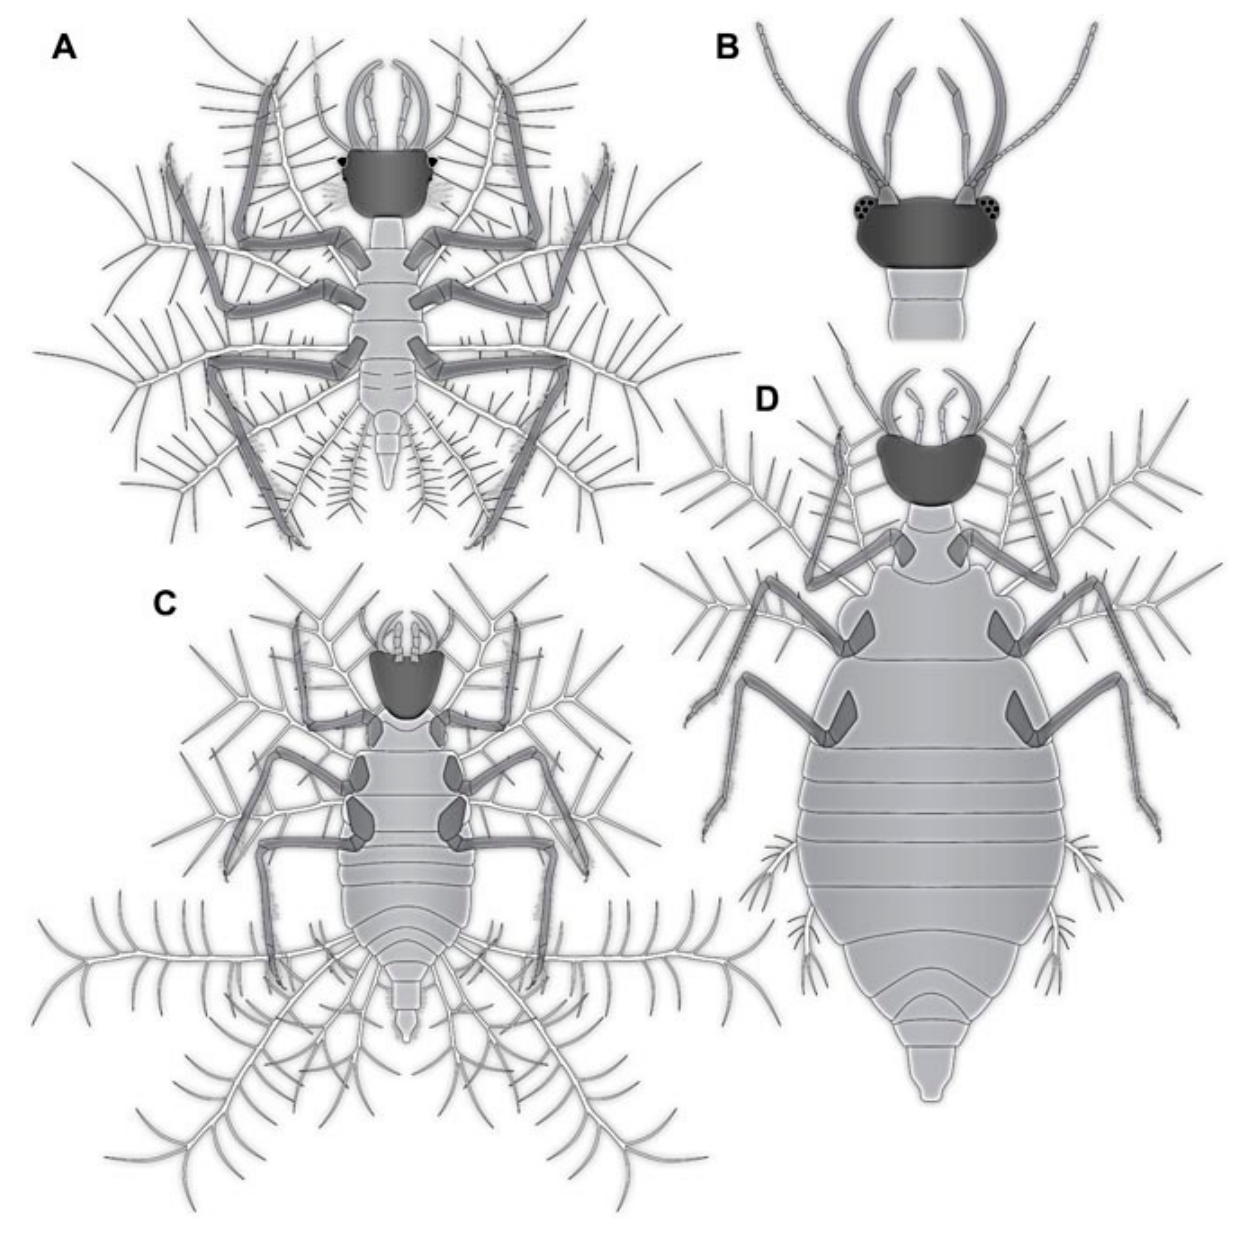
Figure 55. Restorations of some aphidlions, representing major types with processes. ( A ) Type 1, based on BUB 3066 (Figure 2). ( B ) Unclear type, based on BUB 3347 (Figure 3); note the strongly rectangular head. ( C ) Type 2, based on BUB 3060 (Figure 1). ( D ) Type 3, based on BUB 3361 (Figure 6).